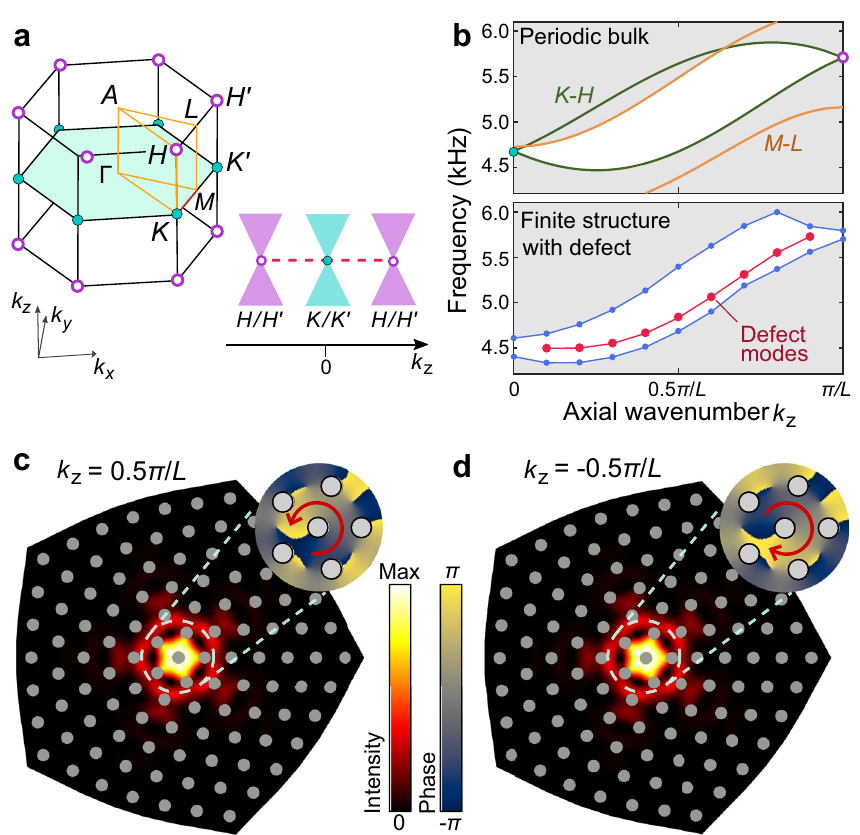
Fig. 2 Numerical characterisation of the TLD-bound modes. a Left panel: 3D Brillouin zone of the acoustic crystal without a TLD. Weyl points occur at K and K 0 with topological charge + 1 (cyan dots), and at H and H 0 with charge − 1 (magenta dots). Right panel: projection of the Weyl points onto k z , with red dashes indicating the TLD-bound modes. b Numerical bandstructures. Upper plot: bands along K - H and M - L for the periodic bulk. Lower plot: bands for a structure with a TLD (with the same cross sectional pro fi le as in Fig. 1b – e) and periodicity L along z ; band edge (in-gap) modes are plotted in blue (red). In-gap regions are shown in white. All bands, including the TLD-bound modes, are symmetric around k z = 0; only the k z > 0 range is plotted here. c , d Calculated acoustic pressure intensity distributions in the x – y plane, with z at the midpoint of the structure ’ s central air sheet, for the TLD-bound modes at k z = π /2 L ( c ) and k z = − π /2 L ( d ). Both modes have frequency 4.844 kHz. The grey circles are the solid rods passing through the air sheet. Insets: phase distribution of acoustic pressure near the TLD, showing that the two modes have opposite